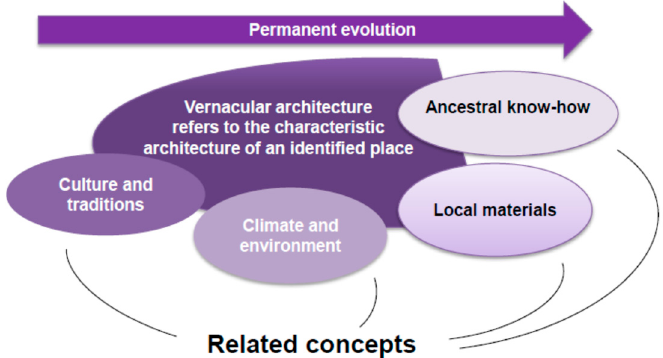
Figure 1. An illustration of notions associated with the vernacular building concept. Source: [8]